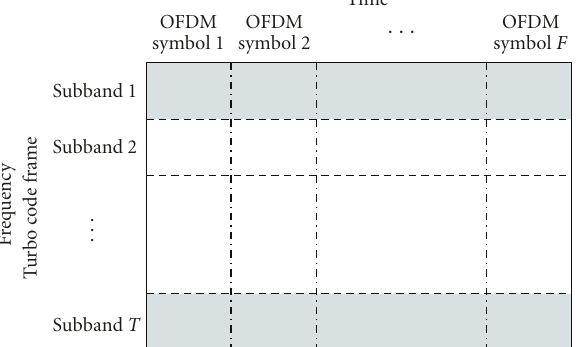
Figure 4: Transmission block structure of one turbo code adaptive